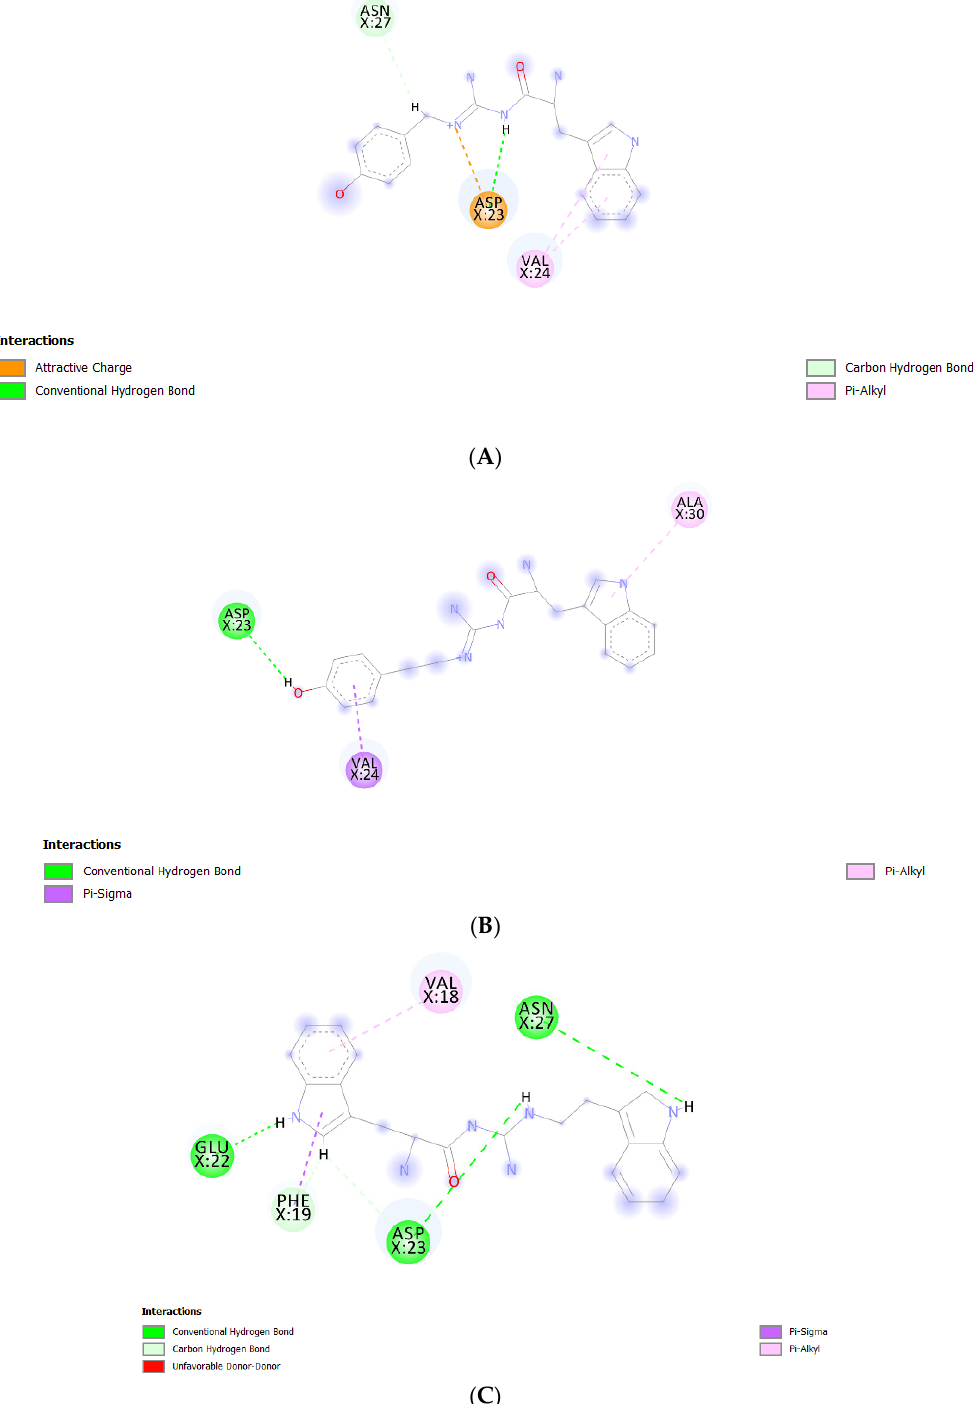
Figure 8. Post-MD simulation binding mode analysis of ( A ) TGN2–, ( B ) TGN3–, and ( C ) TGN4-A β 1–42 monomer complexes.